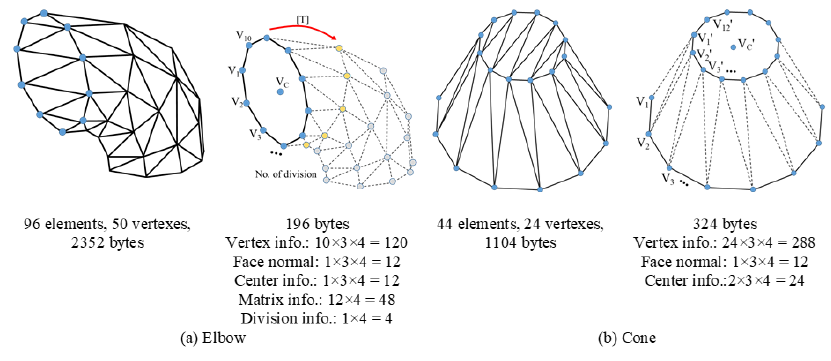
Figure 10. Data size minimization for basic type part.